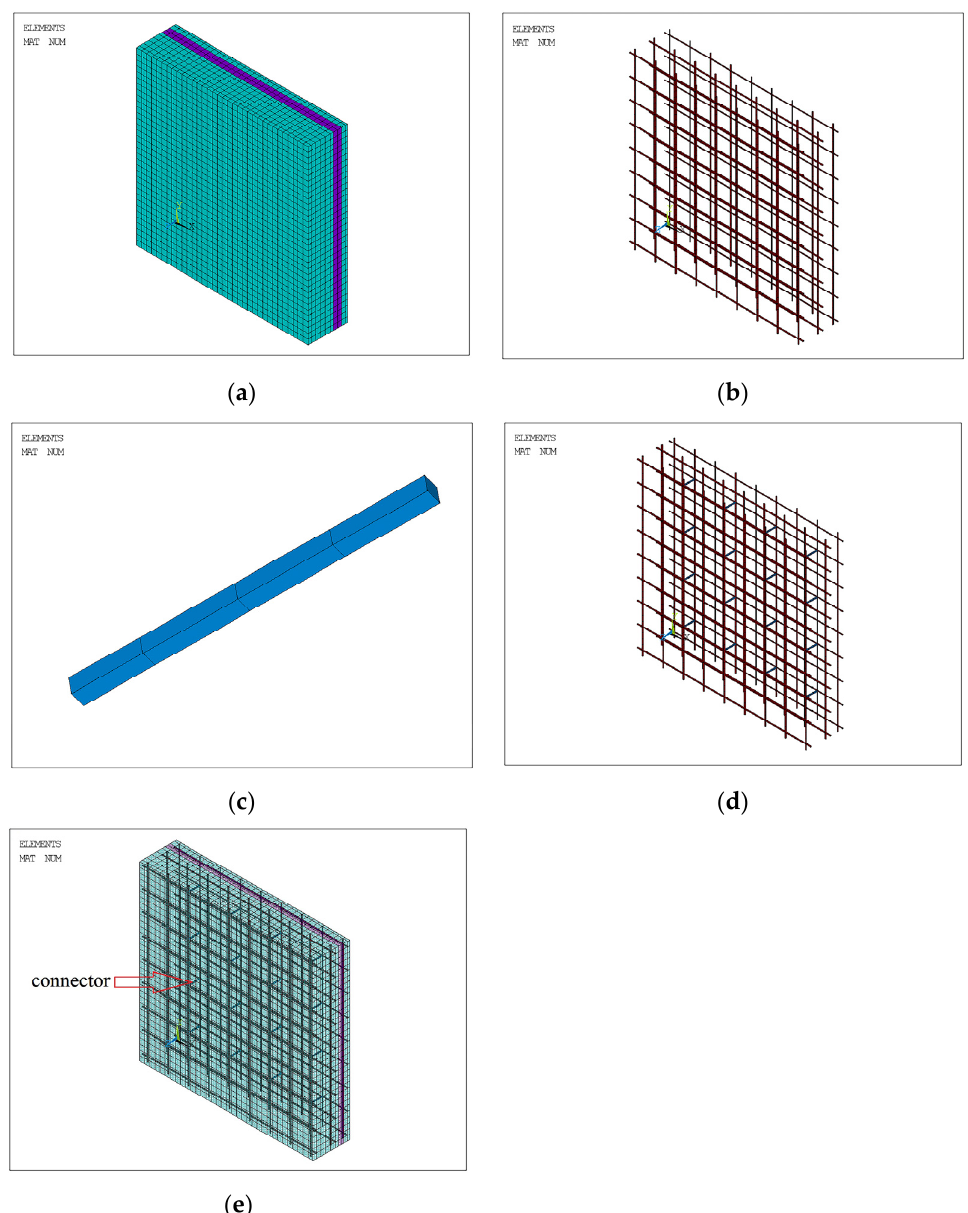
Figure 12. Finite element model: ( a ) concrete and XPS panels; ( b ) rebar; ( c ) connector; ( d ) rebar and connectors; ( e ) whole model.